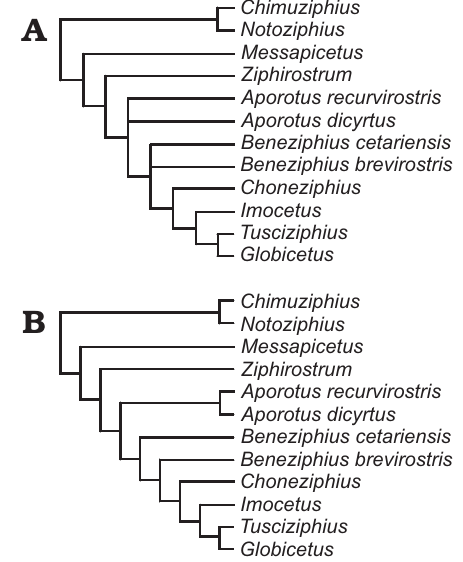
Fig. 5. Detail of the results of the phylogenetic analyses of the family Ziphi idae for the “ Messapicetus clade”. A . Strict consensus of the heuristic search with equally-weighted characters, showing the unresolved relation- ships of Beneziphius cetariensis sp. nov. and B. brevirostris . B . Single most parsimonious tree of the heuristic search with downweighted homoplastic characters (k = 3), with B. cetariensis sp. nov. more stemward than B. bre- virostris . Results for the other parts of the clade Ziphiidae follow Bianucci et al.